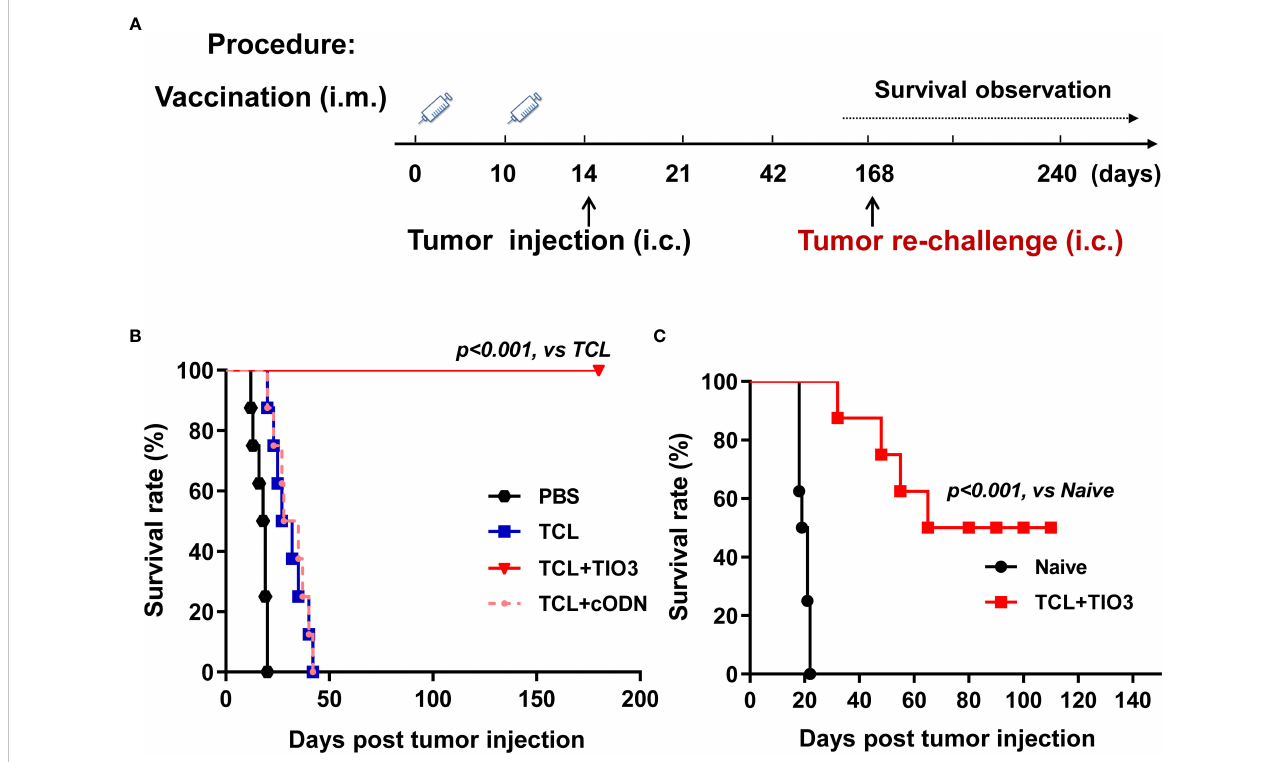
FIGURE 3 Prophylactic protective effect and anti-tumor immune memory of TIO3 as vaccine adjuvant on the in-situ glioma model in mice. (A) The experimental procedure: C57BL/6 mice (n=8) were intramuscularly (i.m.) immunized with PBS, TCL, TCL+TIO3 or TCL+cODN twice on day 0 and day 10, and then were challenged intracranially (i.c.) inoculated with 2×10 4 GL261 cells on day 14. Then, the survived mice were re-challenged with 2×10 4 GL261 cells on day 168, naive mice (n=8) were intracranially inoculated with 2×10 4 GL261 cells; (B) The survival rate of GL261-bearing mice in different groups after the fi rst tumor inoculation. (C) The survival of the mice after tumor re-challenge were observed for another 110